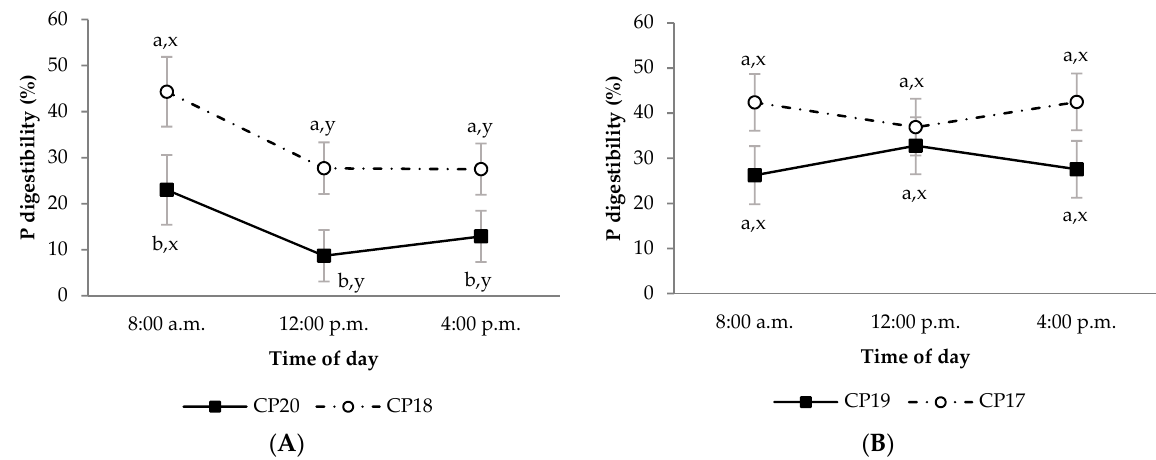
Figure 3. Digestibility of phosphorous (P) in growing ( A ) and finishing ( B ) periods in Ripollesa lambs fed with different concentrations of crude protein were compared between treatments (CP20 vs. CP18 and CP19 vs. CP17) and time of the day (least square mean values ± standard error). Within each sampling hour, different letters (a, b) denote statistical differences ( p ≤ 0.05) between dietary treatments. Within each dietary treatment, different letters (x, y) denote statistical differences ( p ≤ 0.05) between sampling hours.